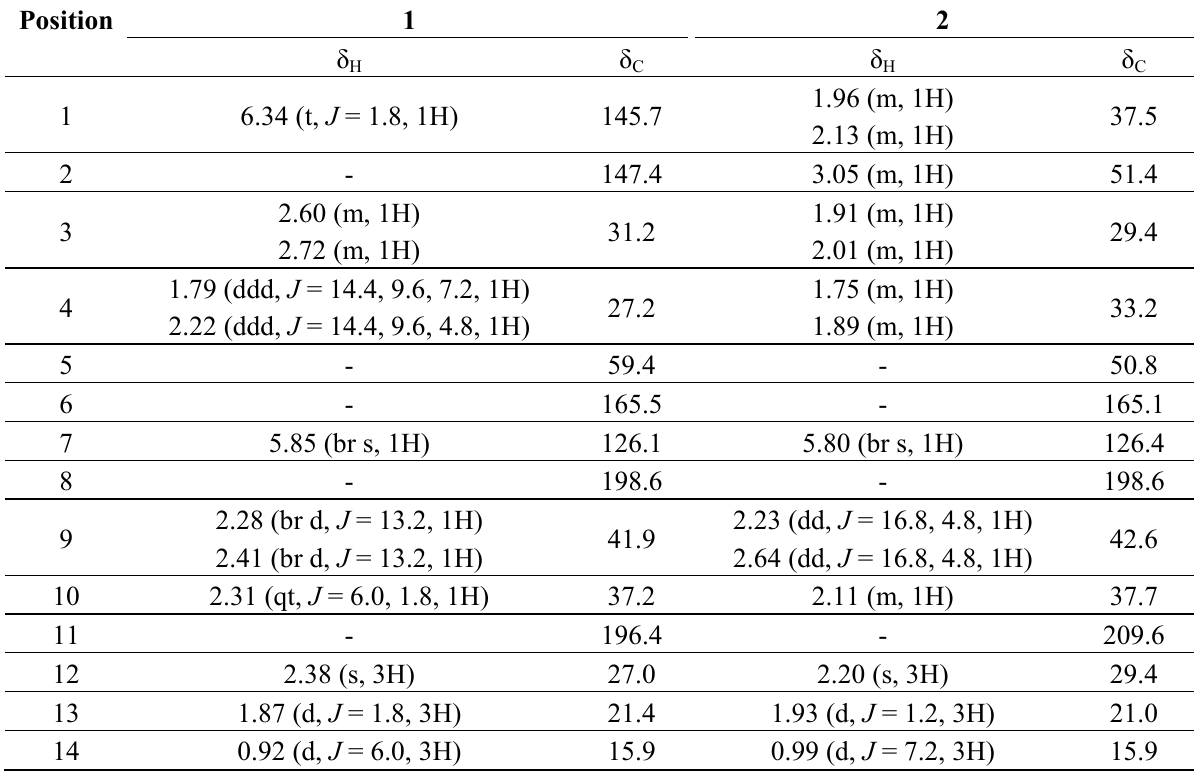
Table 1. 1 H-(600 MHz) and 13 C-NMR (150 MHz) data (CDCl Chemical shifts δ in ppm relative to tetramethylsilant (TMS), J in Hz.